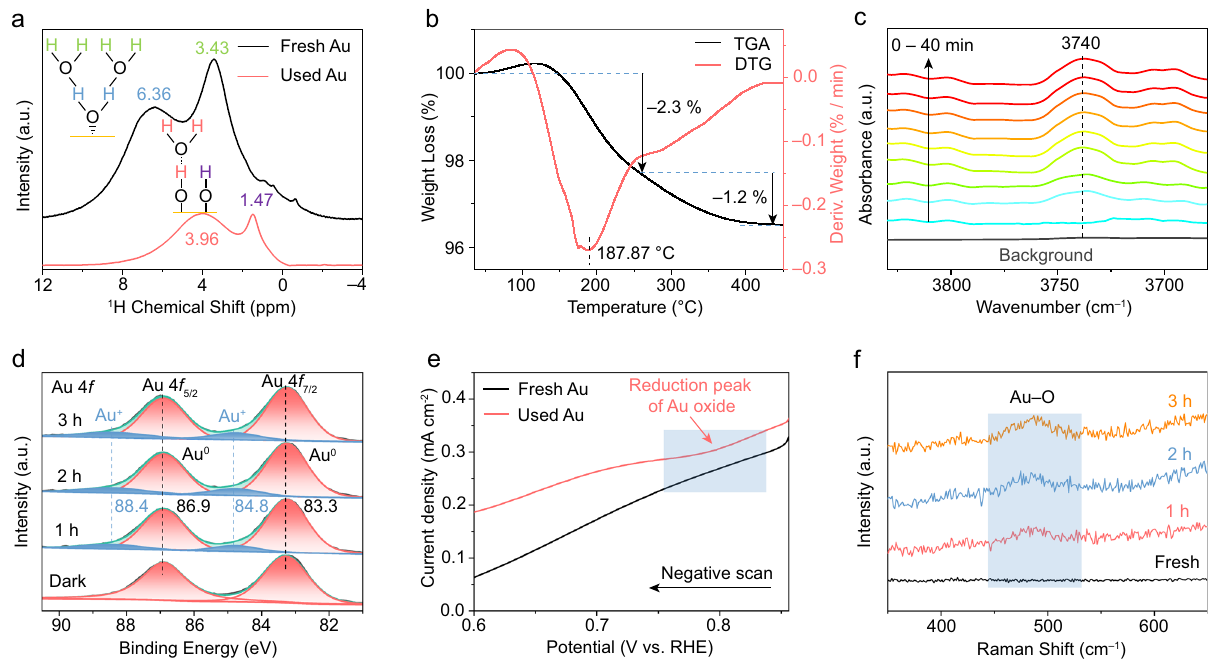
Fig. 4 Characterization of surface Au – O species formed by H 2 O decomposition. a 1 H ssMAS-NMR spectra of Au samples before (black curve) and after CO 2 RR (3 h reaction, red curve). b TGA-DTG curves of the fresh Au photocatalyst. c In situ FT-IR spectra of the photocatalytic CO 2 reduction with H 2 O on Au. FT-IR spectra were recorded every 5 min from bottom to top. d Quasi in situ XPS (Au 4 f ) of Au NPs at photocatalytic reaction times of 0 (fresh), 1, 2, and 3 h. e LSV curves of fresh and used (3 h reaction) Au catalyst. f Raman spectra of Au NPs at photocatalytic reaction times of 0 (fresh), 1, 2, and 3